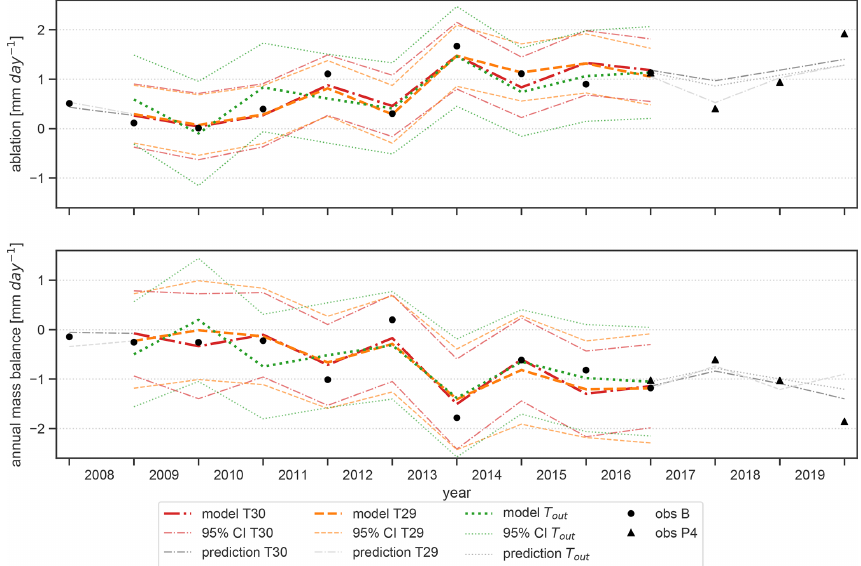
Figure 11. Linear regression models of ablation at stake B. Model T29 uses positive degree days during the ablation period at T29 as a predictor, model T30 uses positive degree days during the preceding accumulation period as a predictor, and model T out uses the freezing degree days during the preceding accumulation period. Lower panel: linear regression model of the annual mass balance at stake B. Model T29 combines positive degree days during the ablation period and freezing degree days in the preceding accumulation period as predictors, model T30 uses both positive and freezing degree days during the accumulation period as predictors, and model T out uses freezing degree days during the accumulation period as a single predictor. Both panels: the years for which the models were fitted (2009 to 2017) are plotted in colour; thin dashed/dotted lines above and below the model line denote the 95% confidence intervals (CIs) of each model. Grey lines show the out-of-sample prediction of the models; the different black markers denote observations at stakes B and P4. For key metrics of the models refer to Table